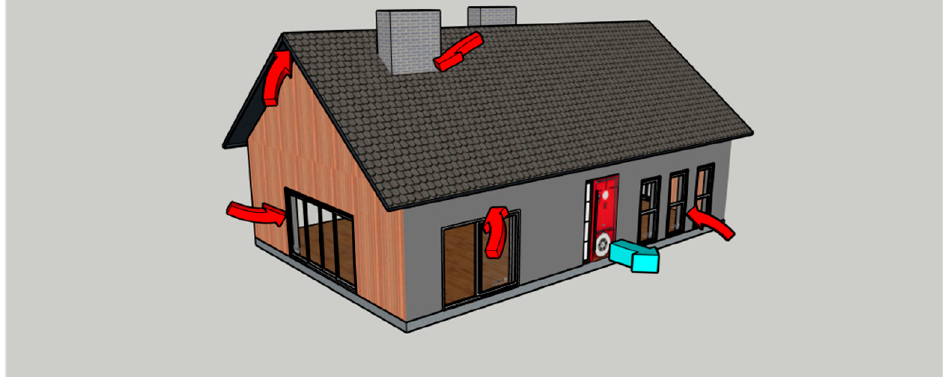
Figure 5. Visualization of the object during the